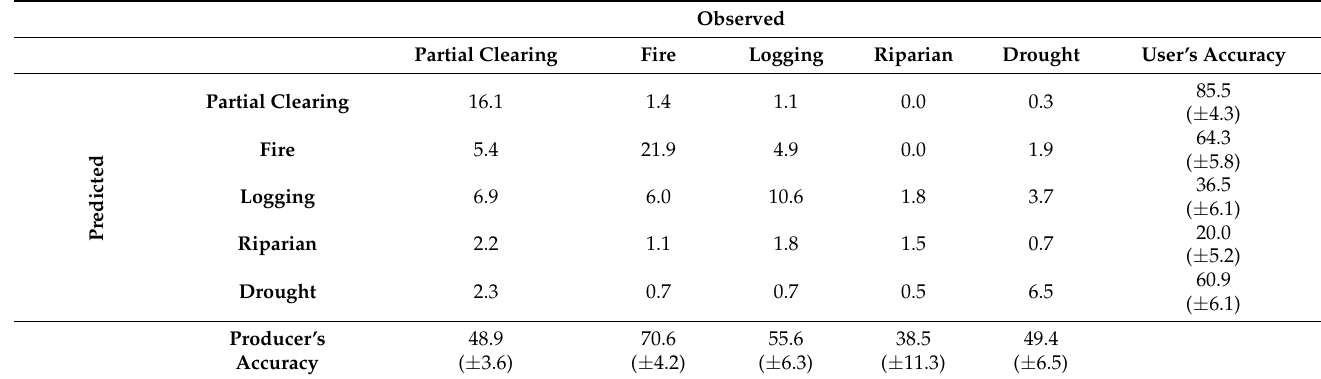
Table 3. Population error matrix showing the estimated percentage of pixels attributed to each agent class in the reference (columns) and by the model predictions (rows), as well as the estimated user’s and producer’s accuracies per disturbance agent class with the relative standard error.